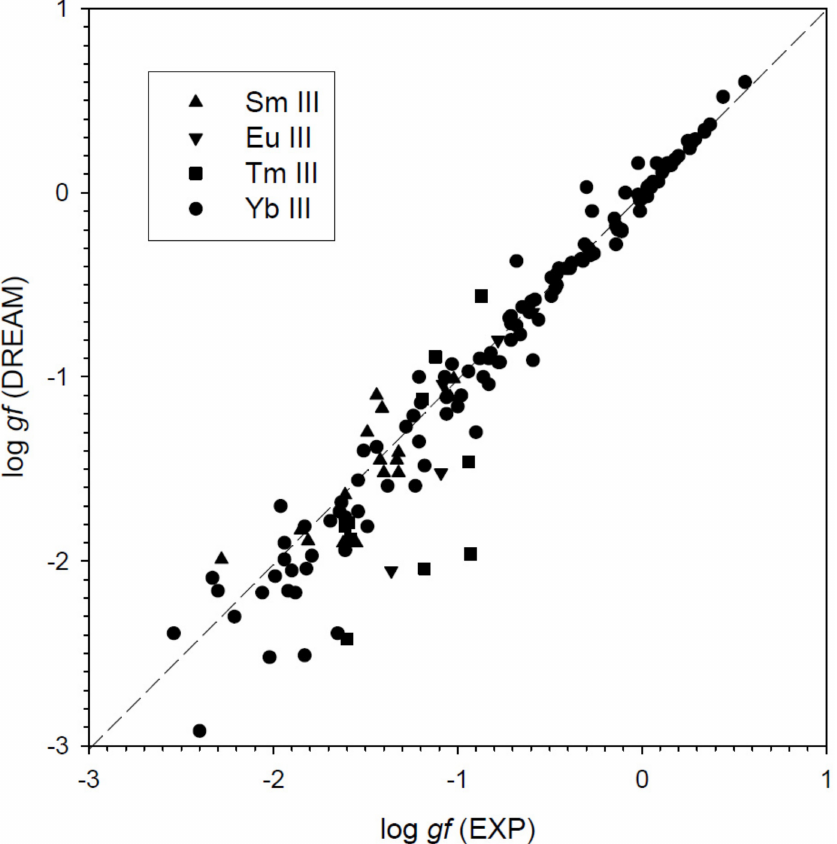
Figure 4. Comparison between the calculated oscillator strengths tabulated in the DREAM database and the experimental values obtained for Sm III [34], Eu III [35], Tm III [36], and Yb III